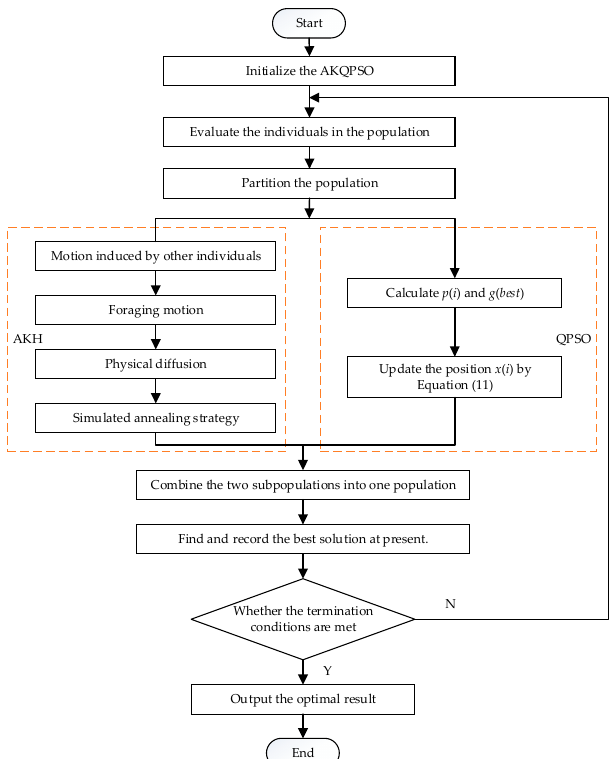
Figure 1. Framework of annealing krill quantum particle swarm optimization (AKQPSO).